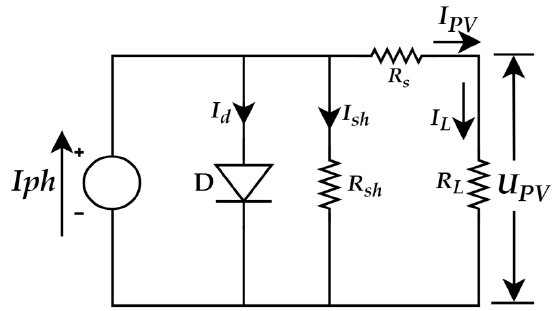
Figure 1. Equivalent circuit of a photovoltaic cell.